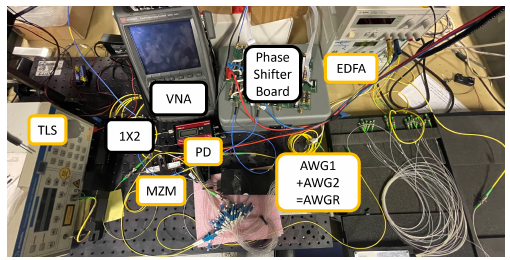
Figure 6. Schematic diagram of the measurement setup.